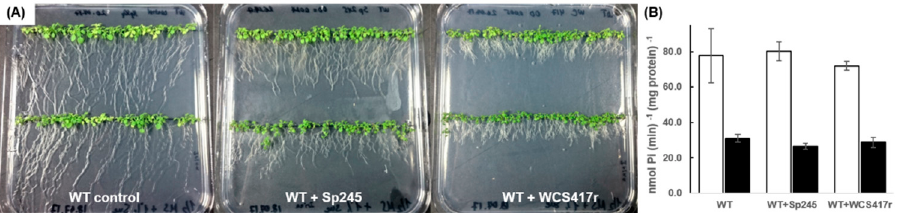
Figure 2. Visual phenotype and PP2A activity of Arabidopsis WT not treated or treated with PGPR. ( A ) Control plants were grown without bacteria (left plate) or co-cultivated with A. brasilense Sp245 (middle plate), or with P. simiae WCS417r (right plate) for 14 days. ( B ) Activity was assayed separately in roots (white bars) and shoots (black bars). Experiments were repeated three times. Values for plants treated with bacteria were not significantly different from non-treated plants at p < 0.1, SE is given.